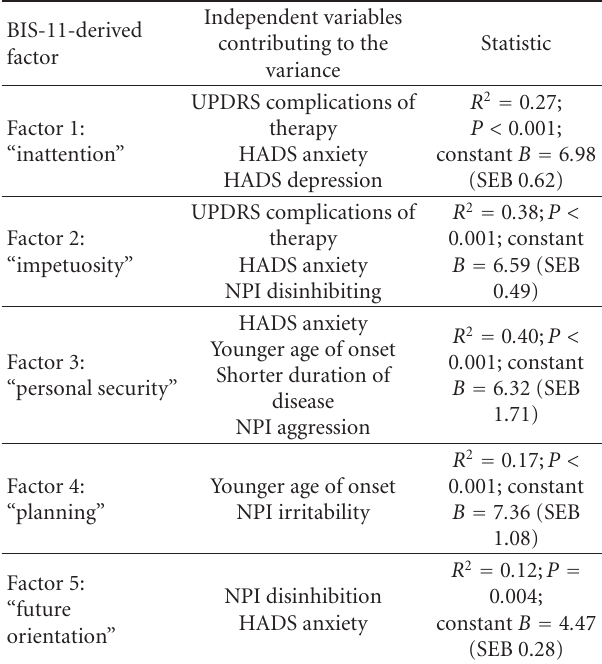
Table 6: Forced linear regressions with BIS-11-derived factors 1 to 5 as the dependent